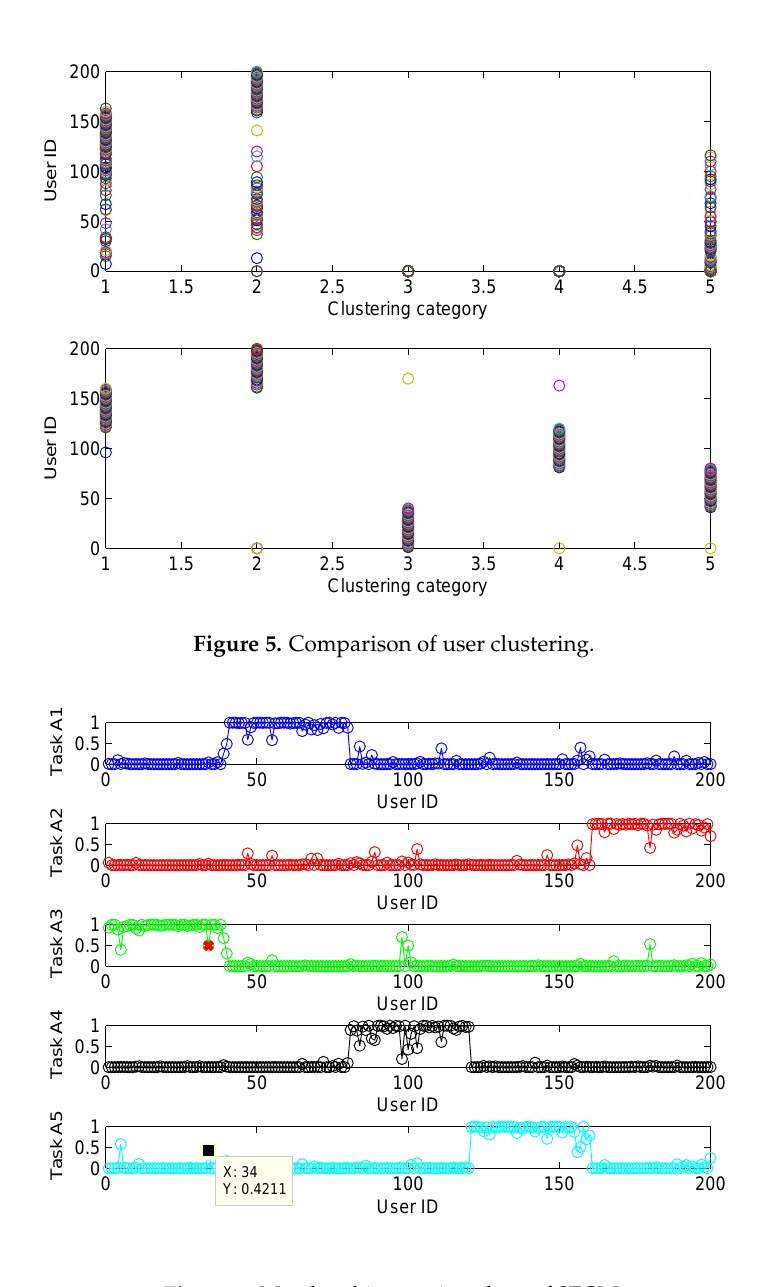
Figure 6. Membership matrix values of SFCM. Table 2. Similar membership values of randomly tested